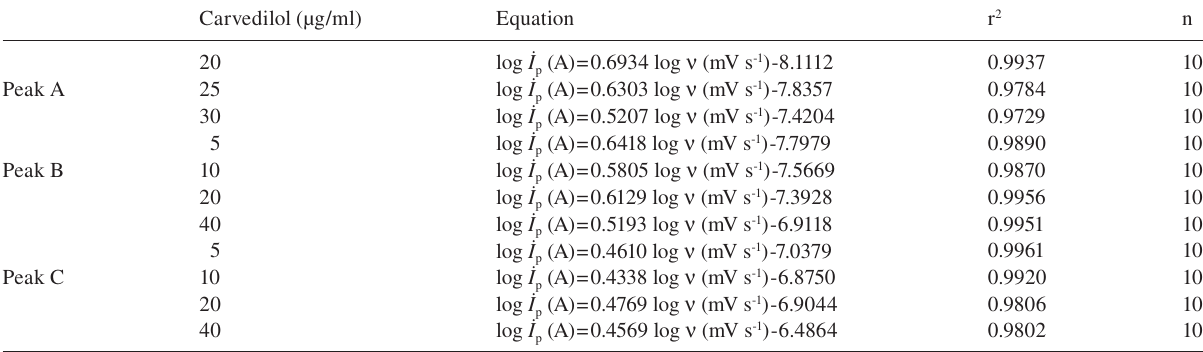
Table 1 Logarithm of peak current-logarithm of scan rate results for voltammetric waves. Carvedilol ( µ g/ml) Equation r 2